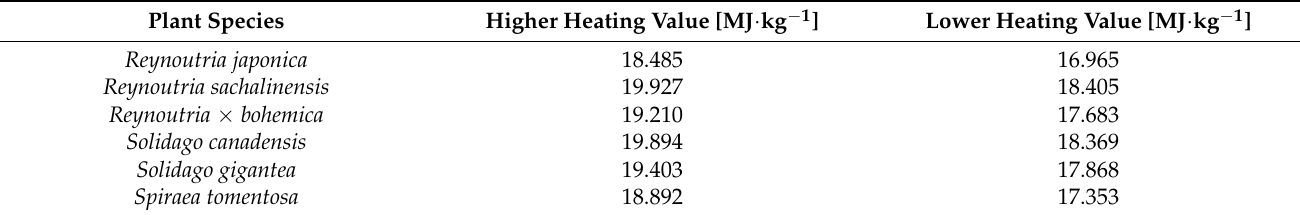
Table 2. The higher heating value and lower heating value of the invasive plant species. Plant